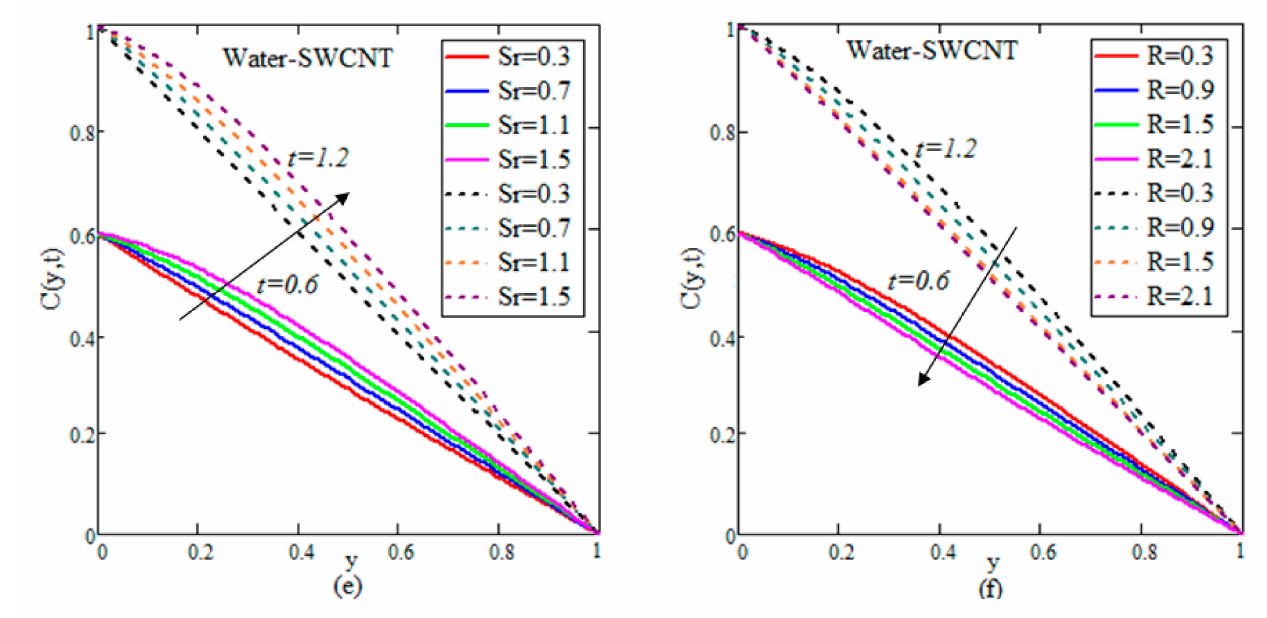
Figure 3. ( a – f ) Deviation of concentrations.